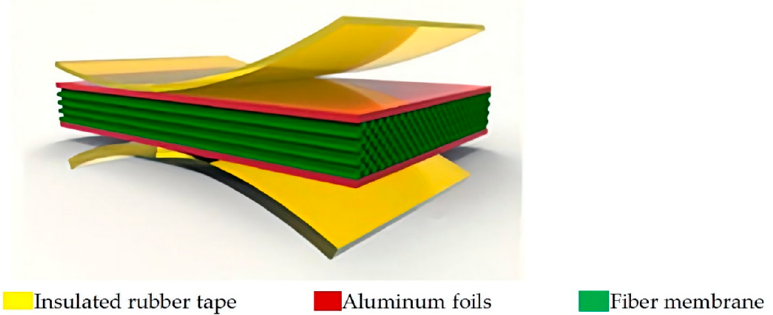
Figure 3. Piezoelectric signal generator.